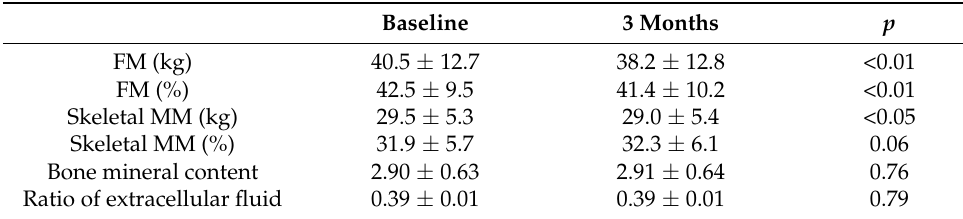
Table 2. Time-course changes in body composition after semaglutide treatment.